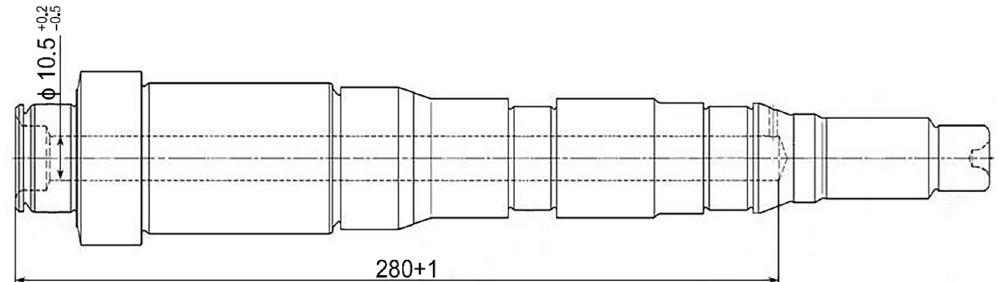
Figure 4. Transmission shaft of the part tested in the experiment.